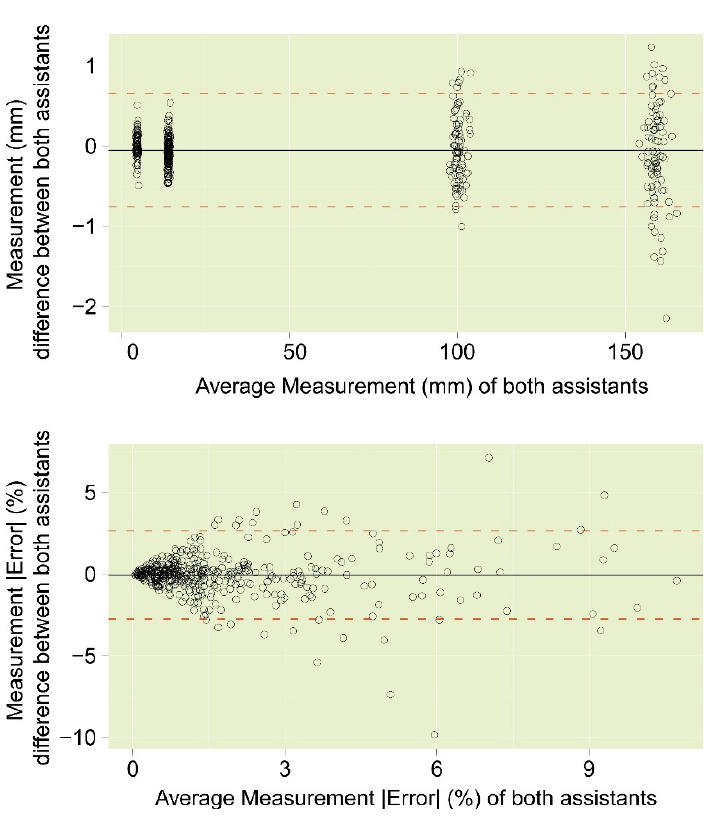
Figure 12. Bland–Altman plots of the inter-observer test results for ( Top ) the measurement values in mm and ( Bottom ) the percentage absolute measurement errors.